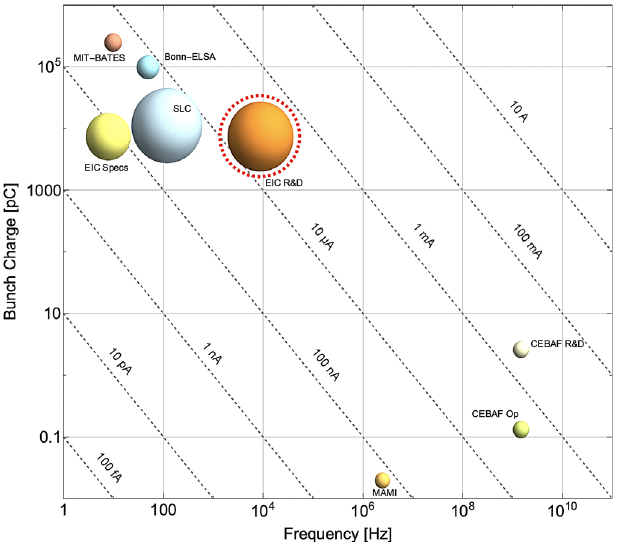
FIG. 13. Comparison of various gun from different facilities around the world. The sloped line shows the average current contour level as labeled. The ball diameter is representative of the peak current of the gun. The red dashed line at EIC R&D shows the maximum achieved peak current of 8